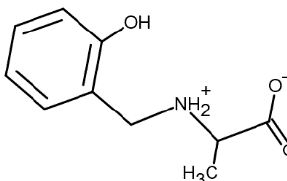
Figure 1. Structure of the ligand N -(2-hydroxybenzyl)alanine, AlaSal (zwitter-ionic form [LH 2 ]).